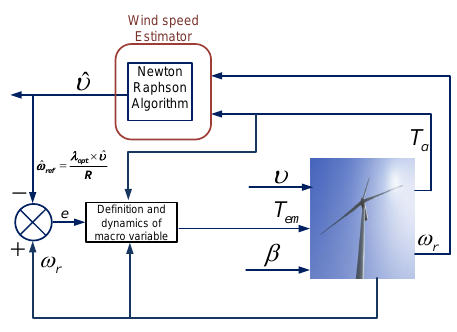
Figure 4. Wind speed